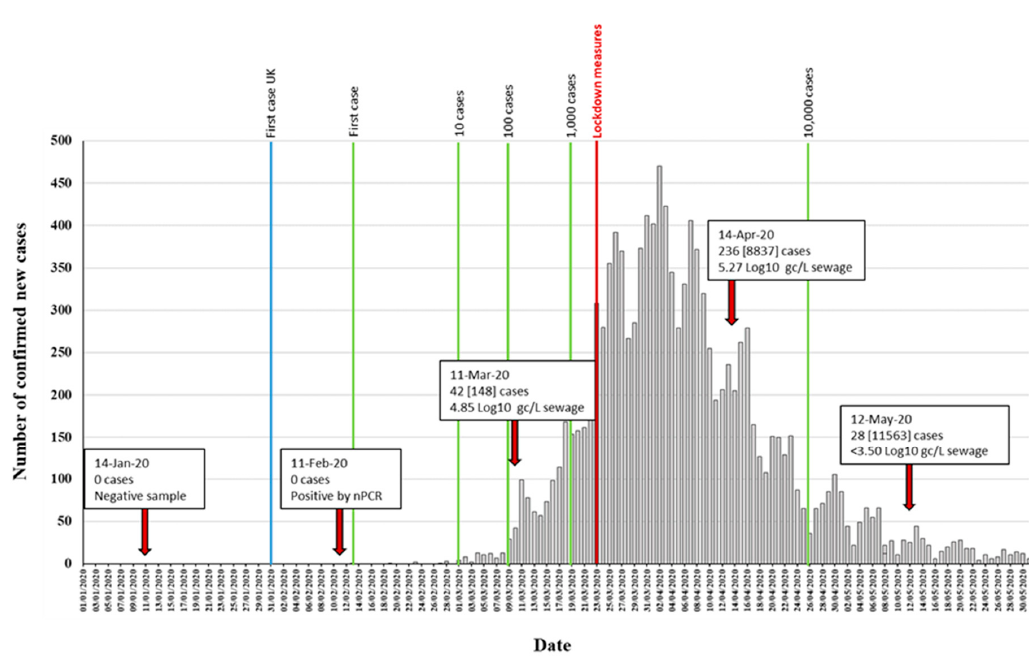
Figure 3. Detection of SARS-CoV-2 RNA in relation to COVID-19 confirmed cases. The number of daily reported new COVID-19 cases in the catchment area covered by the sewage plant is shown as grey columns. The time points at which 1, 10, 100, 1000, and 10,000 confirmed cases where reached in the area are indicated with green vertical lines. The blue vertical line indicates the time point of the first U.K. confirmed case, outside the sampling area. Environmental surveillance (ES) sampling time points are shown with red arrows. Data on SARS-CoV-2 viral RNA detection is shown in boxes. The number of daily new cases (with total accumulated cases in brackets) at each sampling date is shown. RTqPCR quantification results obtained with the RdRP reaction are shown. The time point at which lockdown measures were introduced is indicated in red. Source for COVID-19 cases data: https: // coronavirus.data.gov.uk / , accessed on 4 July